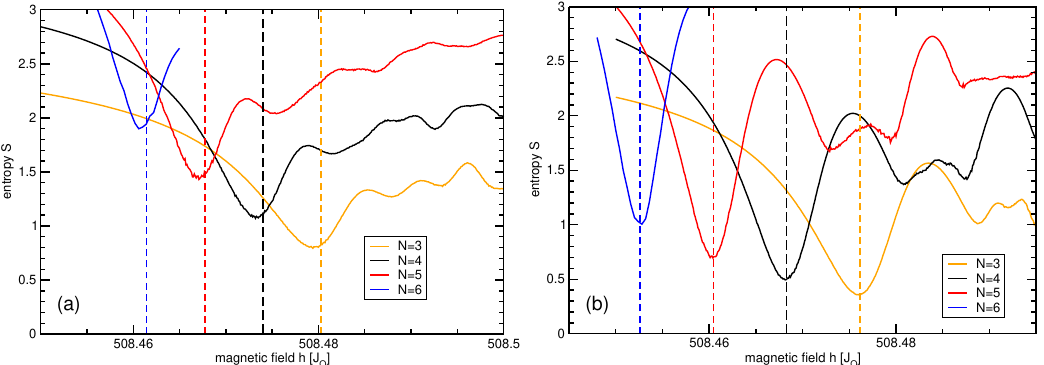
Figure 8: Residual entropy as function of the applied magnetic field for various bath sizes N for the exponentially distributed couplings given by (9); panel (a) for α = 1 and panel (b) for α = 0.5 and hence smaller ratio J